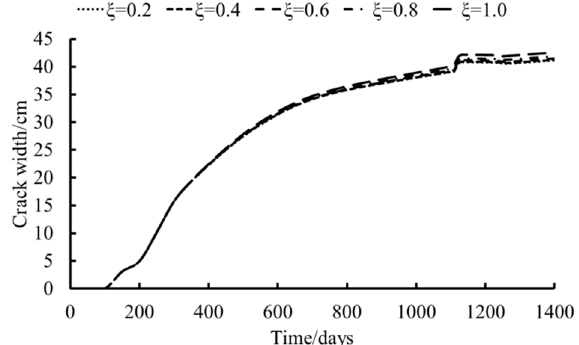
Figure 9. Crack-width–time curve under different discharge speeds.